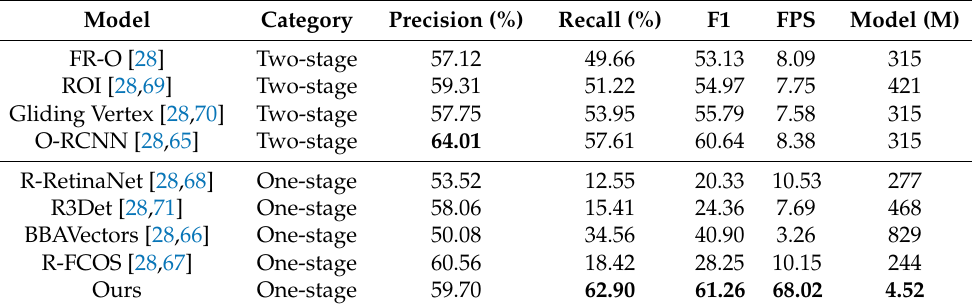
Table 6. Detection results of different CNN-based methods on SRSDD-v1.0.